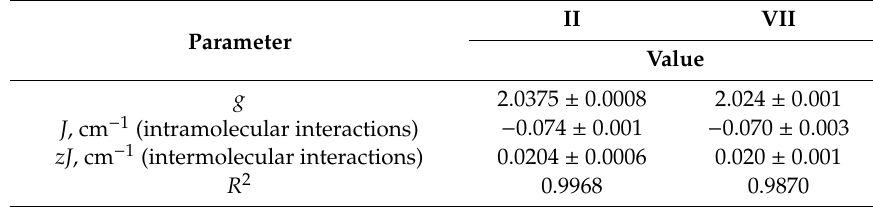
Table 5. Approximation parameters of χ M T(T) dependences for complexes II and VII calculated by means of the PHI program